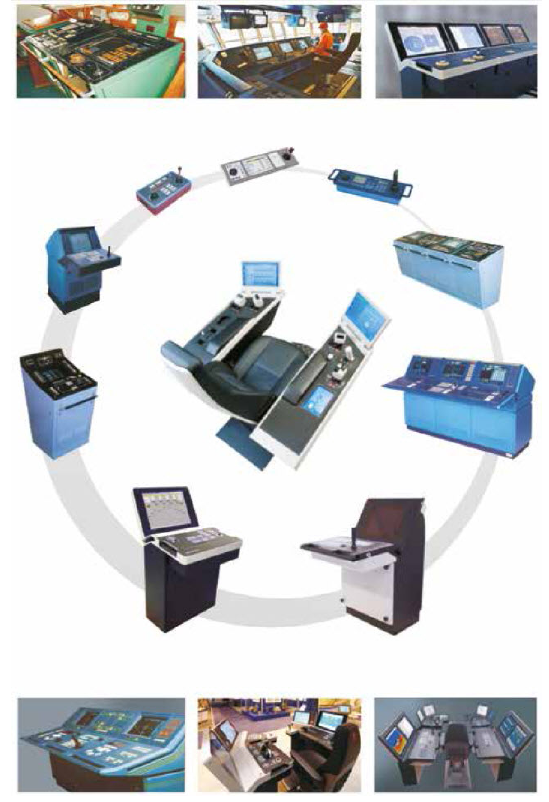
Figure 10: Through the years, DP operator stations have changed significantly, being adapted for different vessel types. Illustration: